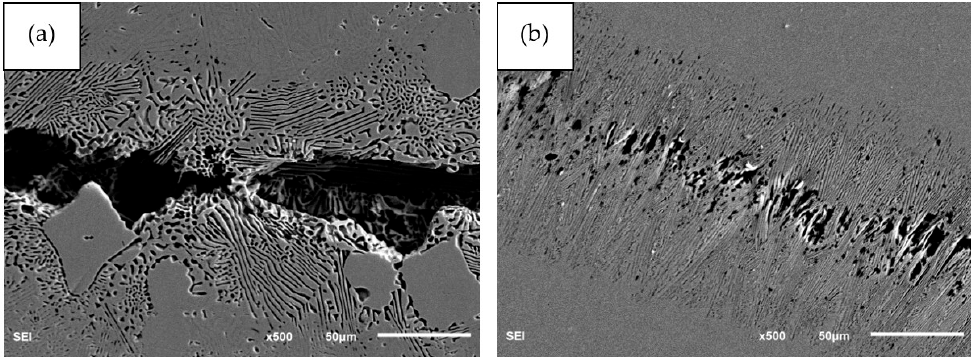
Figure 9. Corrosion morphology of AlCoCrFeNi 2.1 HEA: ( a ) as-cast; ( b )